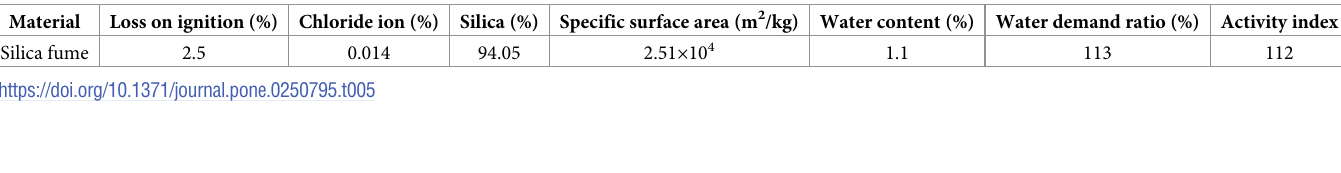
Table 5. Property indices of the silica